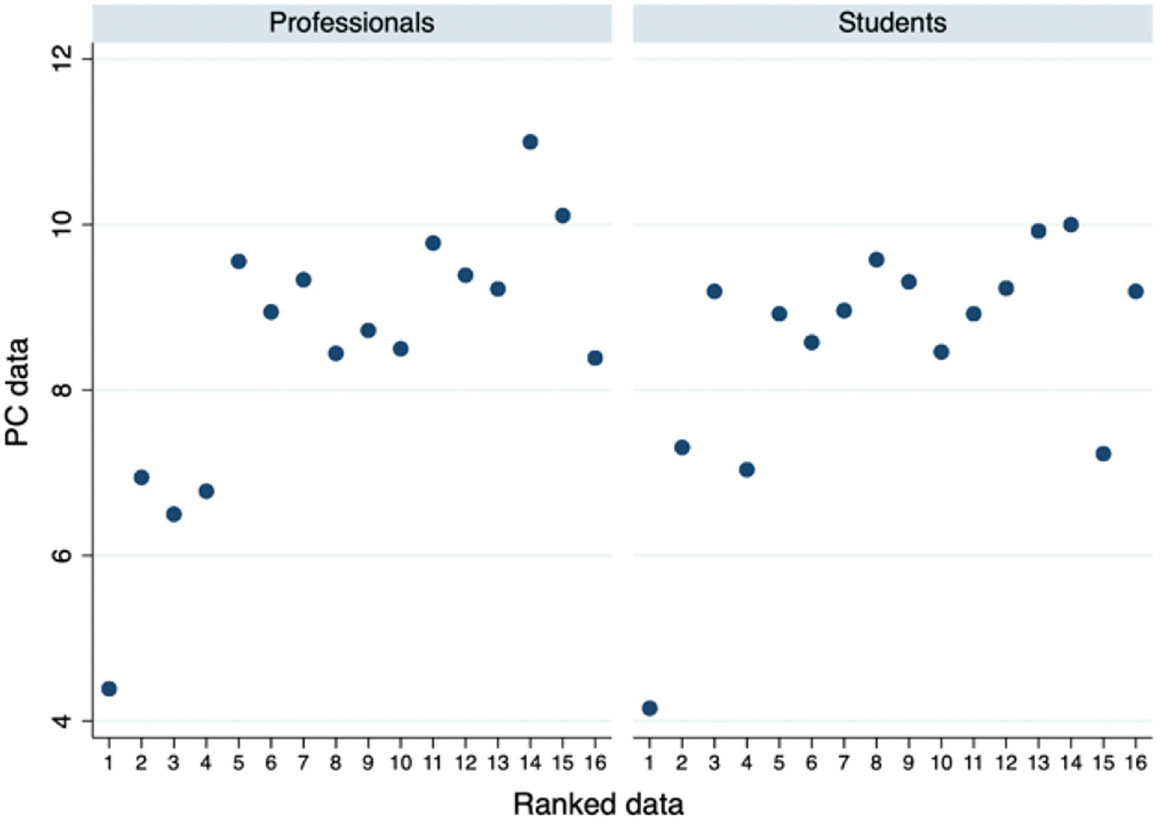
Fig 4. Policy-capturing vs. ranked data by sample. The relationship between Policy-capturing data and Ranked data by sample group.